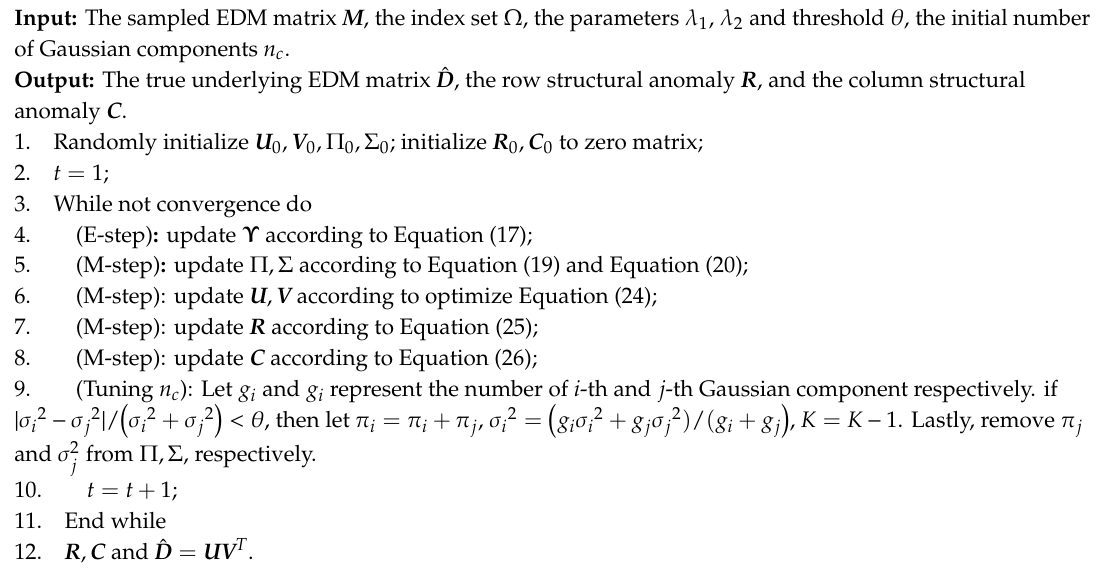
Algorithm 1. Proposed Robust (cid:96) 2,1 -norm Regularized Matrix Decomposition (RRMD)